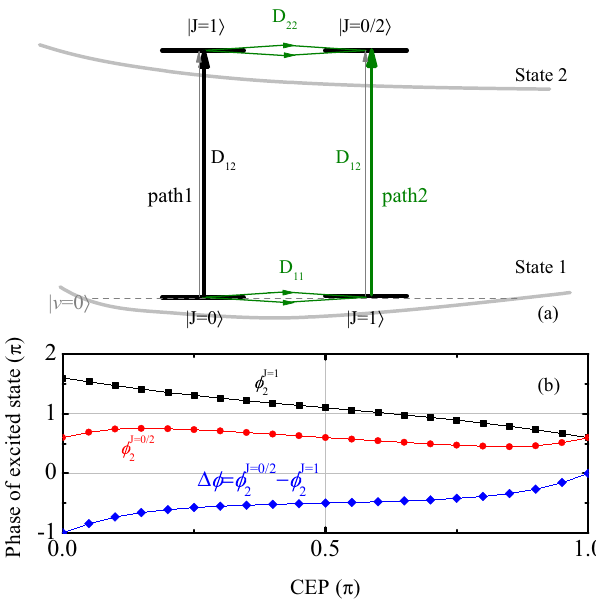
0.0 Fig. 2 Model excitation and relative phase. a The excitation scheme in a weak sub-cycle UV fi eld: `path1' is the electronic excitation by interaction D J ¼ 1 j i (two vertical lines representing two pathways from the 12 to state rotating and counter-rotating terms, where the thick line indicates the predominant contribution of the rotating term); `path2' corresponds to the (cid:1) (cid:3) (cid:1) involving neighboring rotational excitation in excitations to state J ¼ 0 = 2 the lower state (by interaction D 11 ) or the upper state (by interaction D 22 ). The two arrow-curves between neighboring rotational levels indicate the comparable importance of rotating and counter-rotating terms to the rotational excitation. The excitation to higher rotational states are too tiny and not illustrated. b Nontrivial phase ϕ J of rotational state J in electronic 2 (cid:2) state 2 excited by both pathway, and the phase difference Δ ϕ ¼ ϕ J ¼ 0 = 2 2 ϕ J ¼ 1 between the excited rotational states by `path1' and `path2'. Note that 2 the two-pathway can produce constructive or destructive interference results only when the phase difference Δ ϕ ≠ ± π /2, and such interference becomes largest when Δ ϕ reaches 0 or π